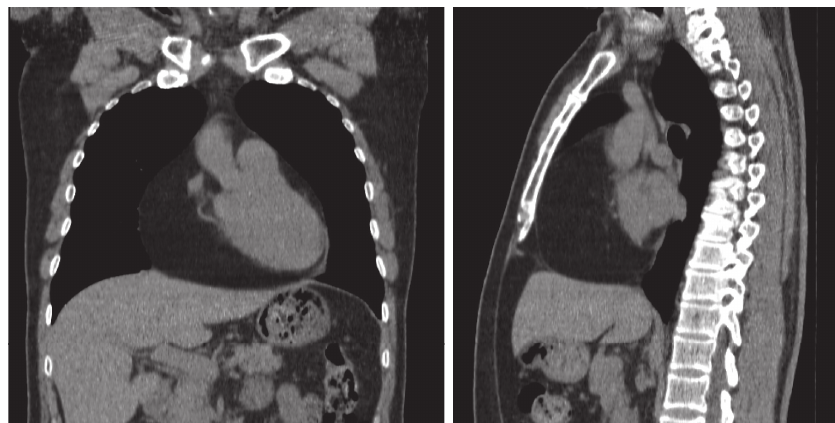
Figure 1: Voluminous pericardial mass. Pericardium tumor with a density similar to fat on a computed tomography scan. Note that the tumor causes posterior displacement of the heart and signs of a reduction in the dimensions of the right heart